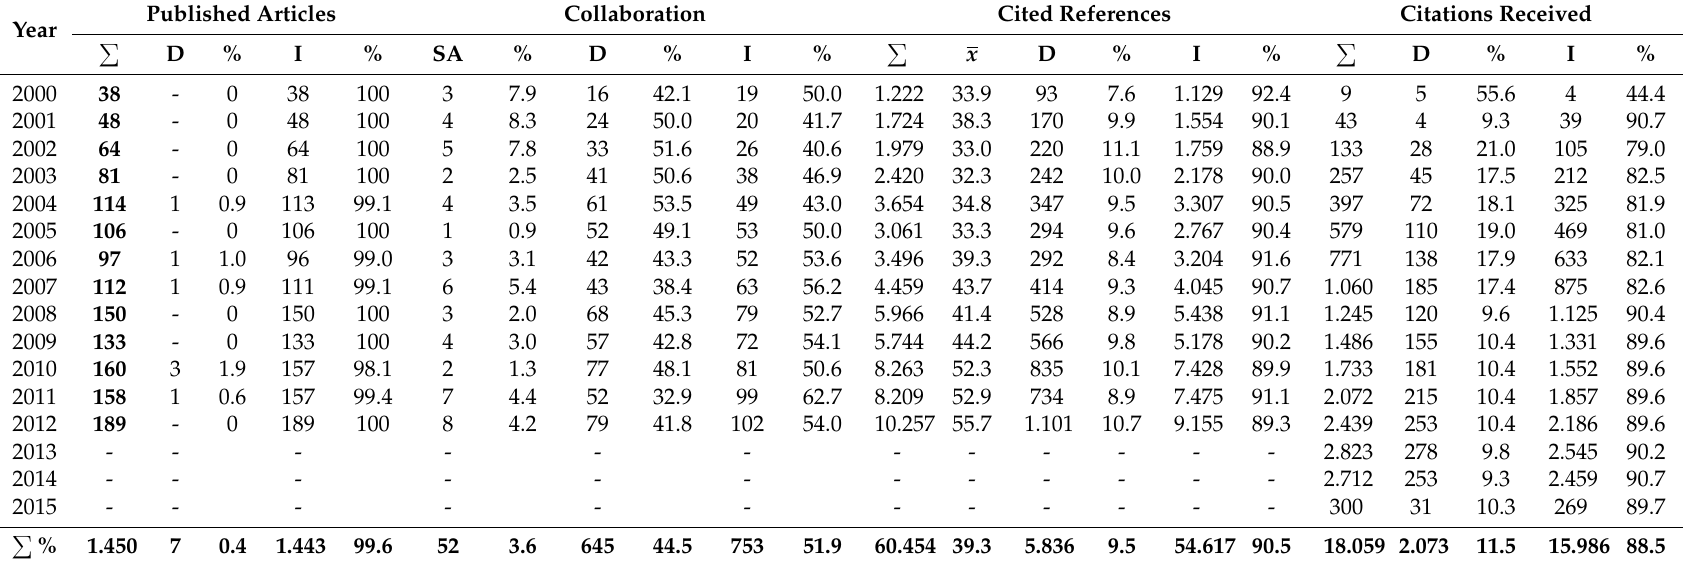
Table 1. Nationality and internationality indicators for Brazilian scientific output in Evolutionary